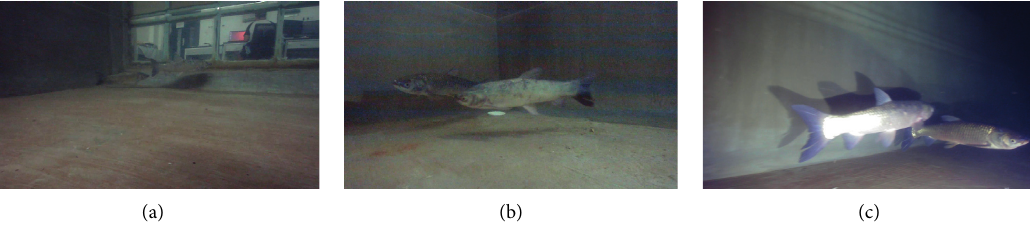
Figure 4: The examples of GCDBR: (a) NL; (b) NOL; (c) NORL.